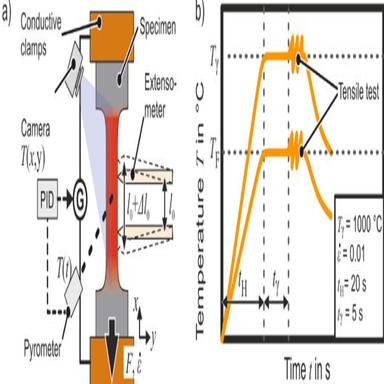
a) Schematic experimental set-up for the hot tensile test and b) exemplary time-temperature-profile T(t) for the experiments.